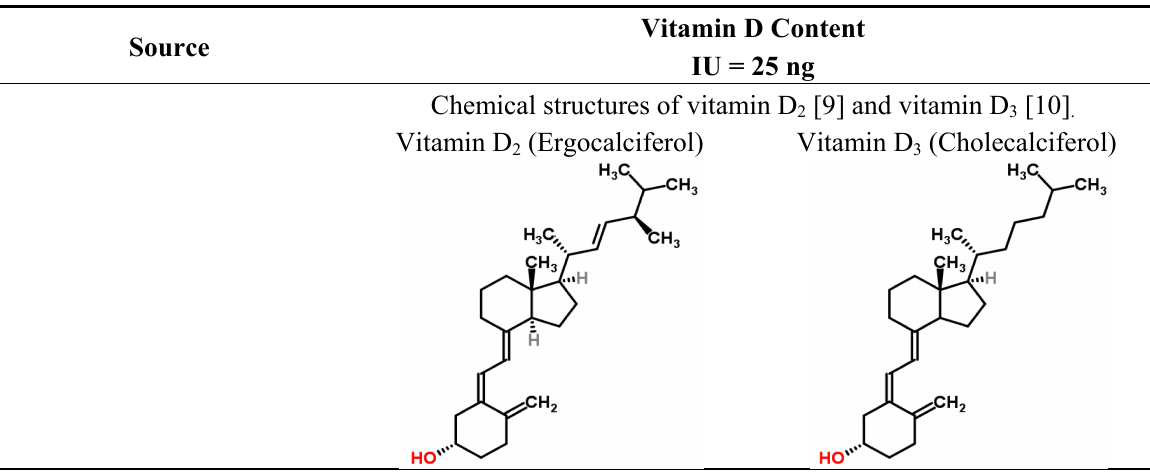
and vitamin D [7]. Note: This table is modified and 2 3